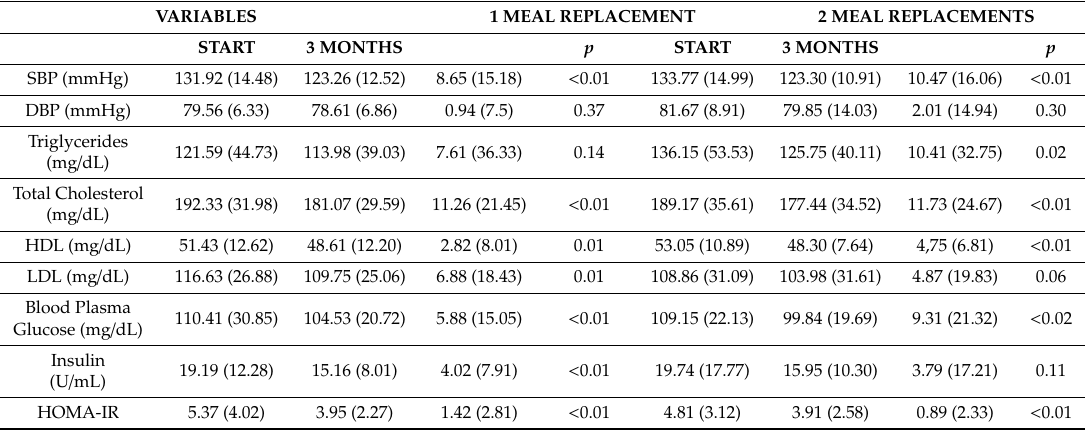
Table 4. Changes in cardiovascular risk parameters before and 3 months after intervention (1 meal replacement vs. 2 meal